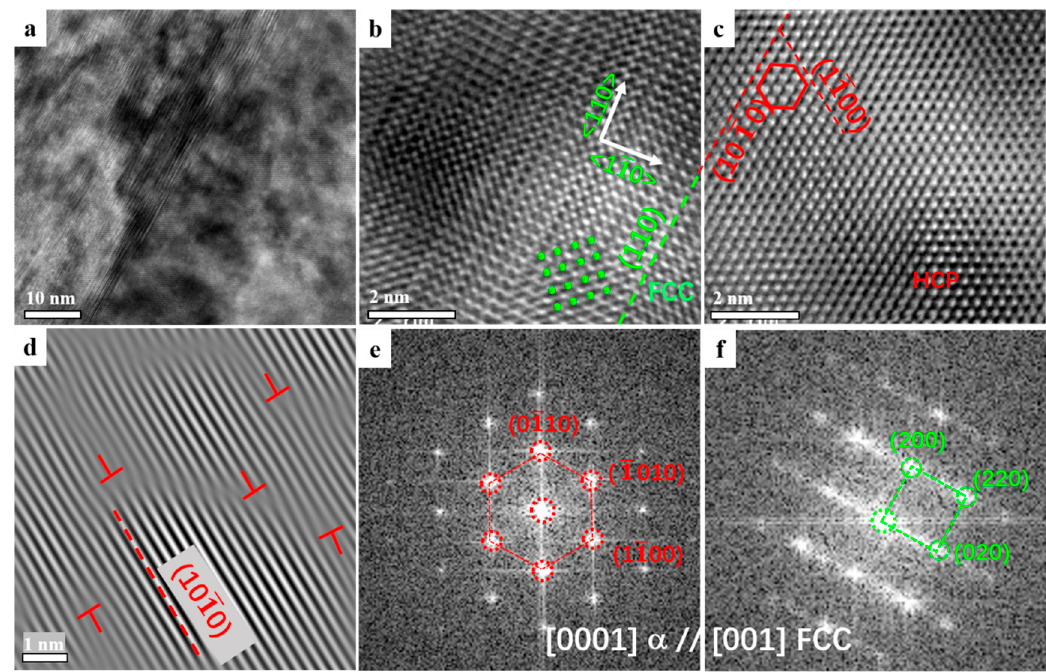
Figure 3. HRTEM and FFT of FCC-Ti laths and HCP matrix. ( a ) HRTEM; ( b , c ) Filter inverse FFT image; ( d ) dislocation in HCP-Ti lath; ( e , f ) FFT patterns of two phases in ( a ).